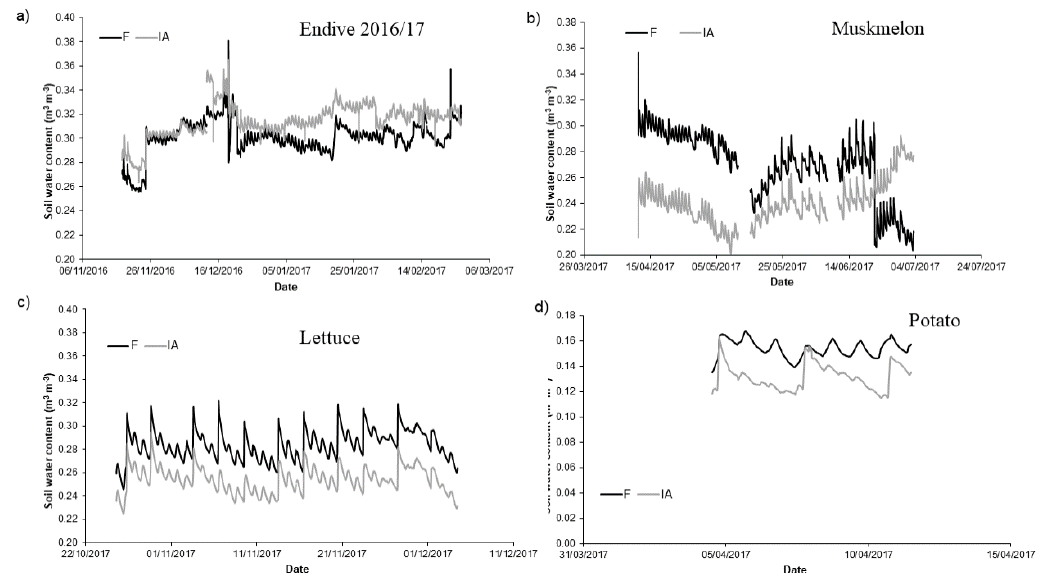
Figure 4. Evolution of soil water content at 20 cm depth in each treatment. F = Irrigation according to farmer’s practices; IA = irrigation according to Irrigation-Advisor recommendations: ( a ) Endive 2016 / 17; ( b ) Muskmelon; ( c ) Lettuce; ( d ) Potato. Table 3. Percentage of difference between treatments when compared to the farmer treatment: irrigation water amounts applied, yield and water productivity for the different crop species considered in the current study. F = Irrigation according to farmer’s practices; IA = irrigation according to Irrigation ‐ Advisor recommendations; IA s = Irrigation ‐ Advisor recommendations +25%; IA d = Irrigation ‐ Advisor recommendations –25%.